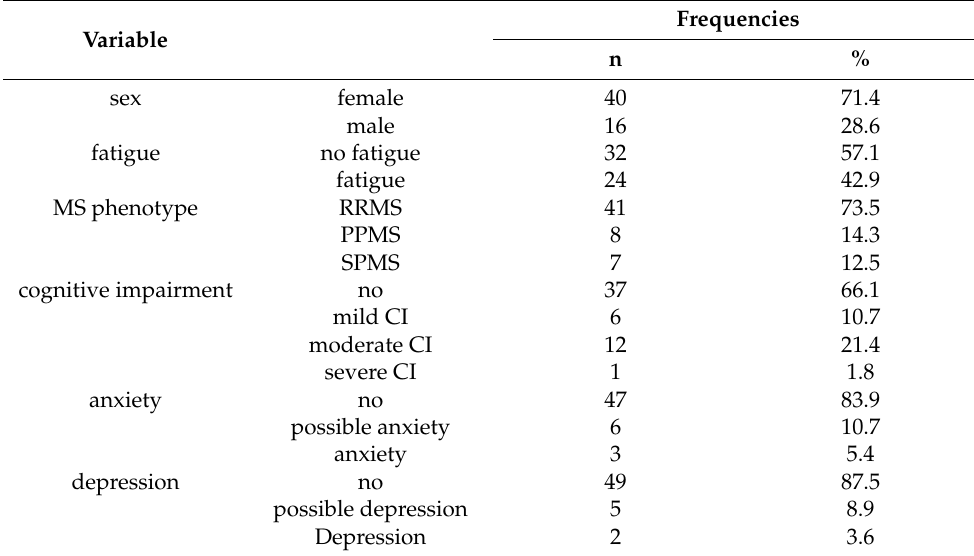
Table 2. Frequencies of Demographic and Clinical Variables (N = 56).